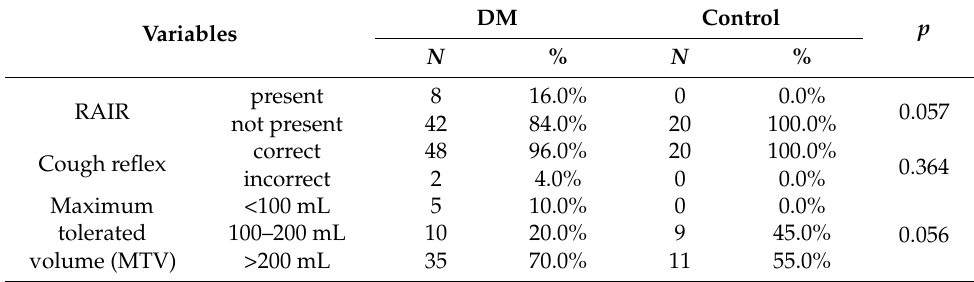
Table 7. Functional manometric tests in diabetic patients and controls.